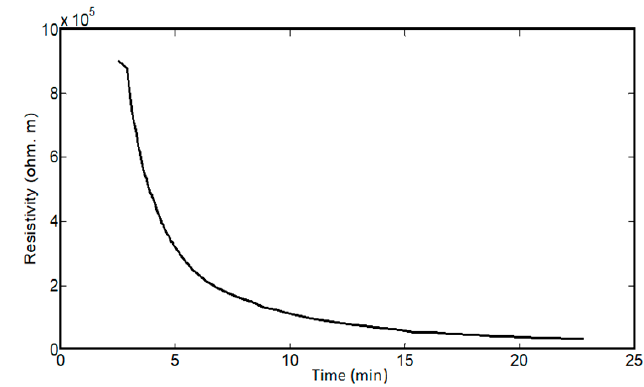
Figure 12. Sharp decay of the diameter of spider silk nanofiber yarns versus time. In the first minute of humidity exposure, the diameter is dramatically decreased.